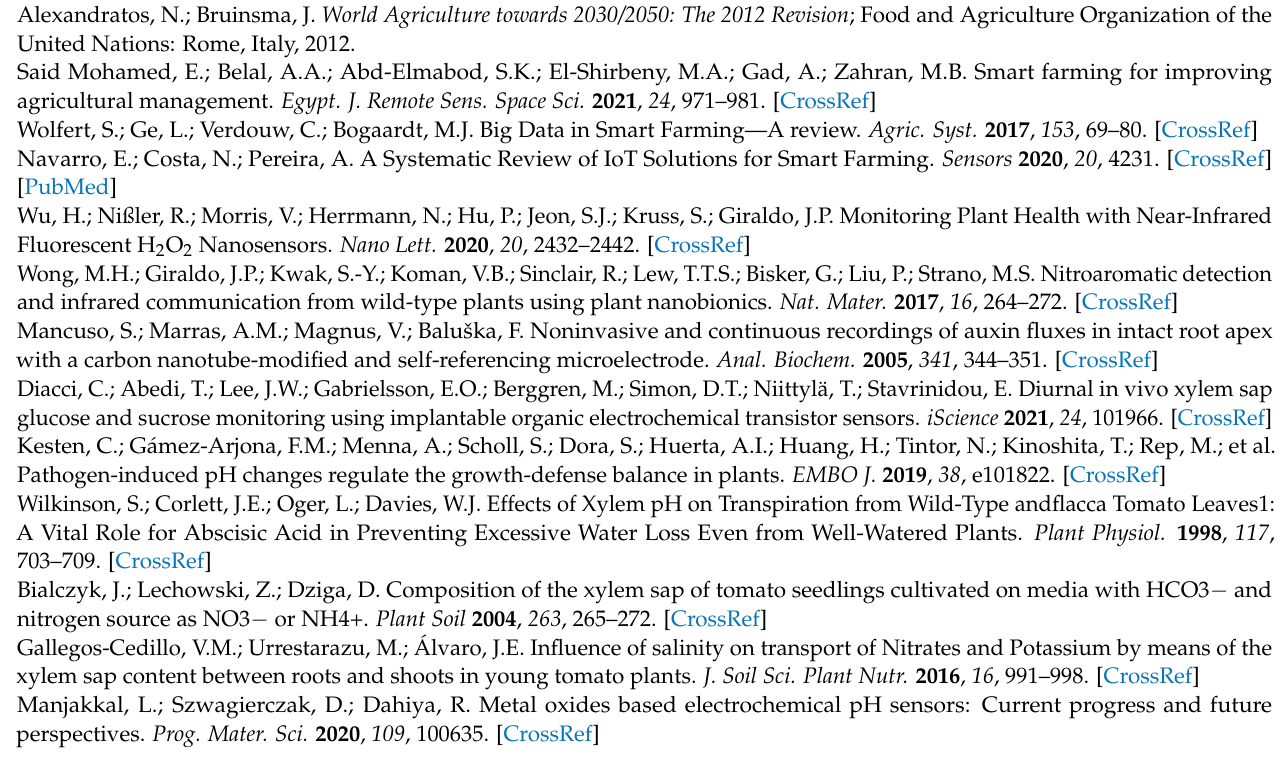
Figure A3. Real vs. imaginary impecance spectroscopy plots obtained from the sensing devices on day 1 and day 7 of continuous exposure with plant tissue. ( a ) Impedance plot obtained from the uncoated RuO x films on day 1. The equivalent circuit employed in this case is also indicated. ( b ) Impedance plot obtained from the EC/PDMS ‐ coated RuO x films on day 1. ( c ) Impedance plot obtained from the uncoated RuO x films on day 7. ( d ) Impedance plot obtained from the EC/PDMS ‐ coated RuO x films on day 7.